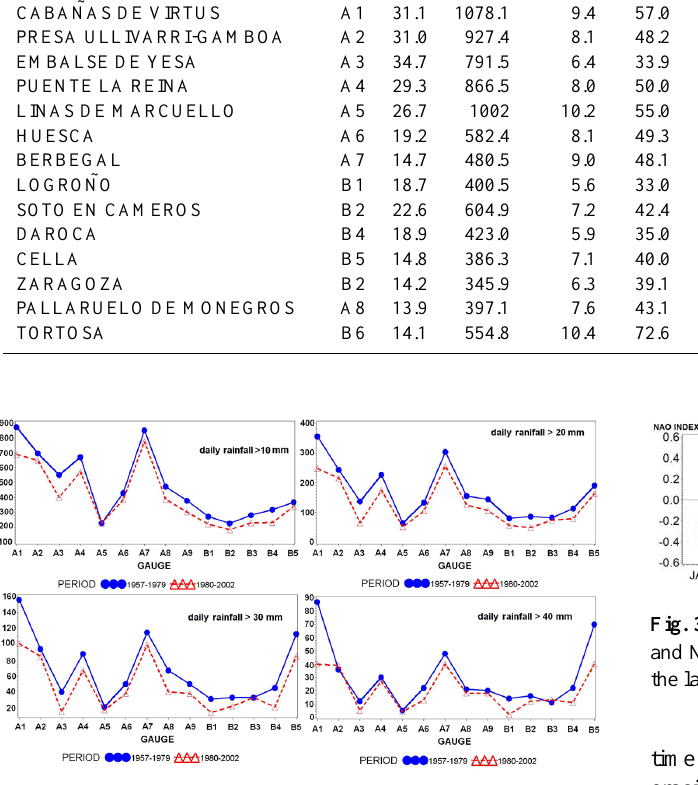
Fig. 2. Number of daily rainfall events exceeding 10, 20, 30 and 40mm of rainfall at each station for two consecutive periods.